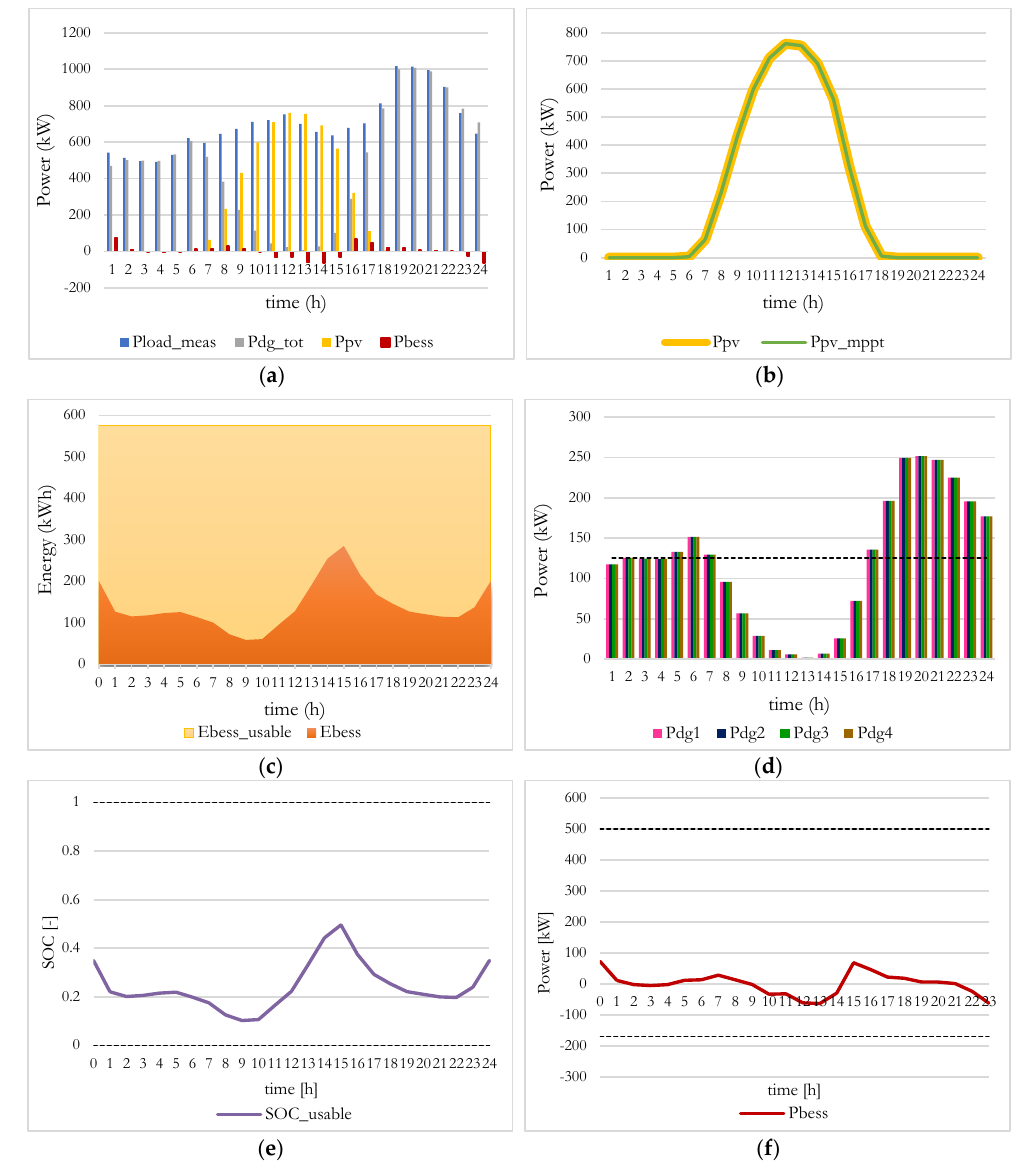
Figure 4. Results of the LP optimization model. ( a ) Main power flows; ( b ) Comparison between MPPT PV power and PV power of LP; ( c ) BESS energy compared to the usable quantity; ( d ) DG power; ( e ) usable SOC; ( f ) BESS power profile.